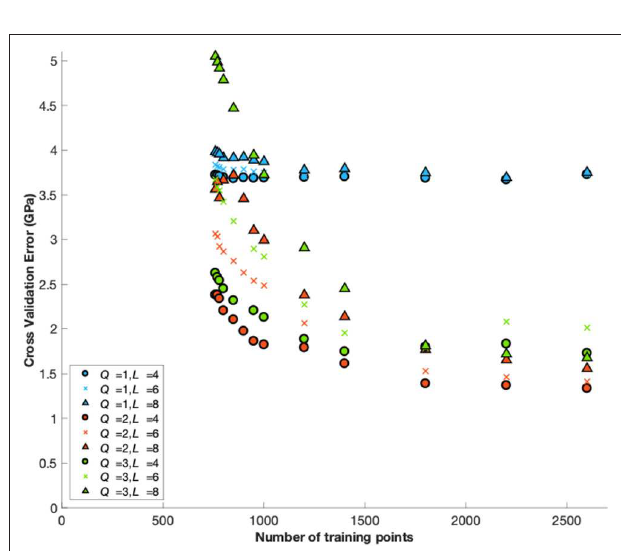
FIGURE 6 | Cross validation error of the reduced-order models built in the first step of the two-step protocol for different truncation levels of Equation (1) for hcp